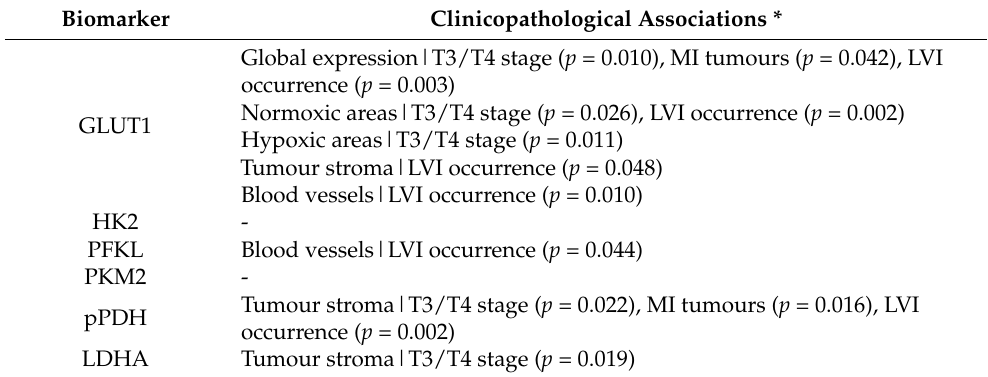
Table 2. Significant associations with clinicopathological parameters of aggressiveness resulting